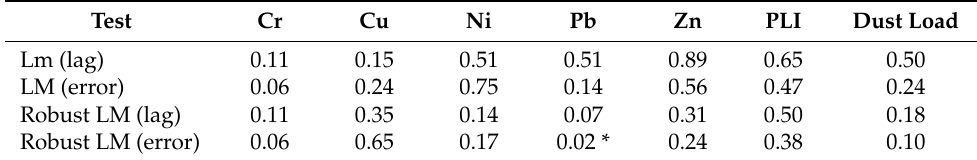
Table 4. p -values of the diagnosis of the ordinary least squares (OLS) regression residuals.